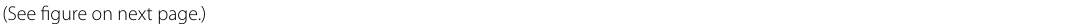
Fig. 11 Microphotographs of calcareous nannofossils taxa found in the investigated samples. Taxa are shown under crossed and parallel nicols as specified and presented as equally sized images to illustrate size differences. A Coccolithus pelagicus subsp. pelagicus (Wallich, 1877) Schiller (1930), crossed nicols, sample: HA 511/11; B Reticulofenestra pseudoumbilicus (Gartner, 1967) Gartner (1969), crossed nicols, sample: HA 511/08; C Reticulofenestra pseudoumbilicus (Gartner, 1967) Gartner (1969), parallel nicols, same specimen as B ; D Reticulofenestra haqii Backman (1978), crossed nicols, Sample: HA 573/07; E Reticulofenestra minuta Roth (1970), crossed nicols, sample: HA 573/07; F Cyclicargolithus floridanus (Roth & Hay, in Hay et al., 1967) Bukry (1971), crossed nicols, sample: HA 573/07; G Calcidiscus premacintyrei Theodoridis (1984), sample: HA 511/08; H Calcidiscus macintyrei (Bukry and Bramlette, 1969) Loeblich and Tappan (1978), crossed nicols, sample HA 511/11; I Umbilicosphaera jafari Muller (1974), crossed nicols, sample HA 511/11; J Umbilicosphaera rotula (Kamptner, 1956) Varol (1982), crossed nicols, sample HA 511/08; K Helicosphaera carteri (Wallich, 1877) Kamptner (1954), crossed nicols, sample HA 66/08; L Helicosphaera carteri (Wallich, 1877) Kamptner (1954), parallel nicols, same specimen as K ; M Helicosphaera vedderi Bukry (1981), crossed nicols, sample HA 66/08; N Helicosphaera vedderi , parallel nicols, sampe specimen as M ; O Helicosphaera stalis Theodoridis (1984), crossed nicols, sample HA 66/08; P Helicosphaera walbersdorfensis Müller (1974), crossed nicols, sample HA 66/08; Q H. walbersdorfensis , parallel nicols, same specimen as P ; R Sphenolithus moriformis (Brönnimann & Stradner, 1960) Bramlette & Wilcoxon (1967), crossed nicols 90°, sample HA 511/08; S S. moriformis , crossed nicols 45°, same specimen as R ; T Discoaster sp. Tan Sin Hok (1927) (cf. D. exilis ; Martini and Bramlette, 1963), parallel nicols, sample HA 511/08; U Discoaster exilis Martini and Bramlette (1963) (cf. D. cauliflorus Browning & Bergen, in Browning et al., 2017), parallel nicols, sample HA 573/07; V Discoaster exilis Martini and Bramlette (1963), parallel nicols, sample HA 66/19; W Rhabdosphaera xiphos (Deflandre & Fert, 1954) Norris (1984), crossed nicols, sample HA 511/11; X Braarudosphaera bigelowii (Gran & Braarud,